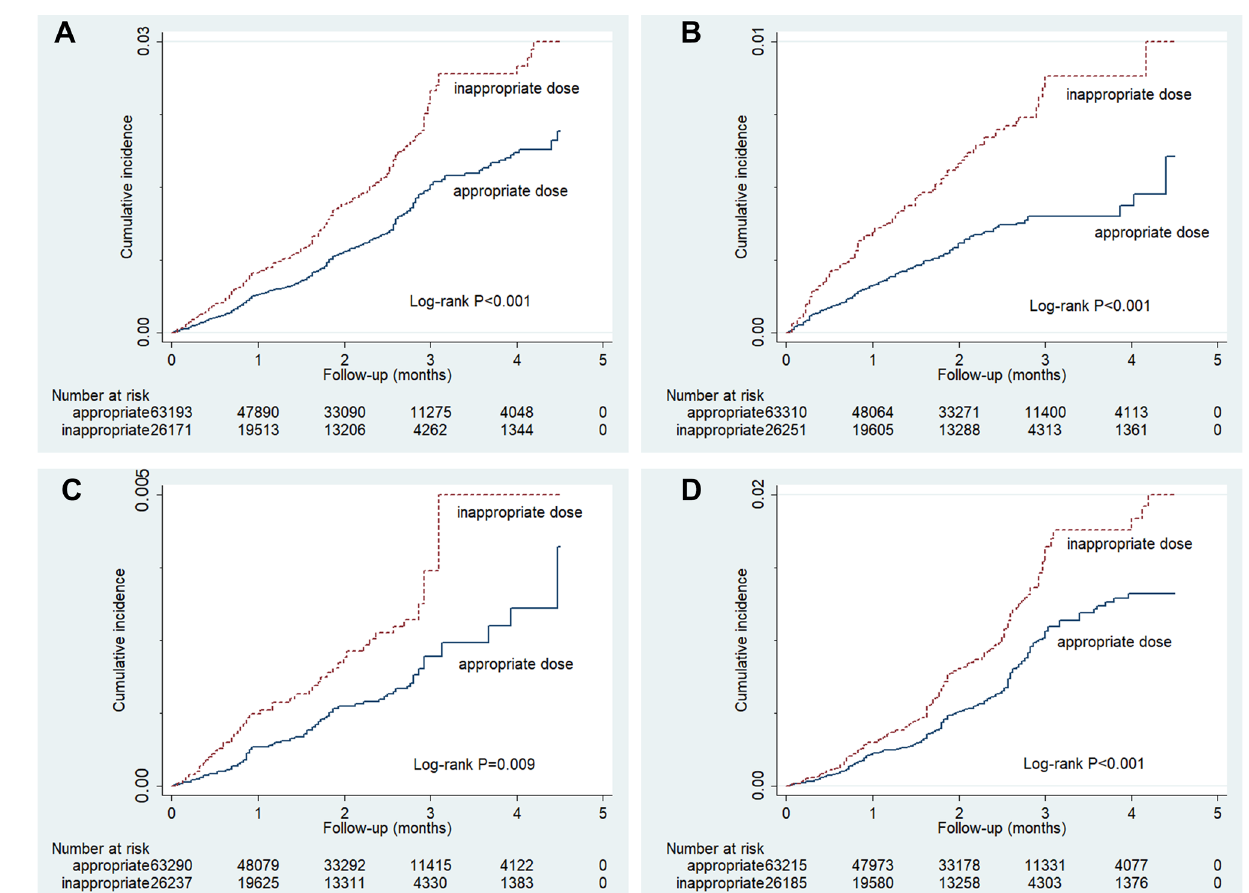
Figure 1. Kaplan–Meier cumulative incidence curve for ( A ) composite of all hypoglycemia, ( B ) severe hypoglycemia, ( C ) moderate hypoglycemia, and ( D ) mild hypoglycemia in patients receiving glucose-lowering drugs with eGFR < 50 mL/min/1.73 m 2